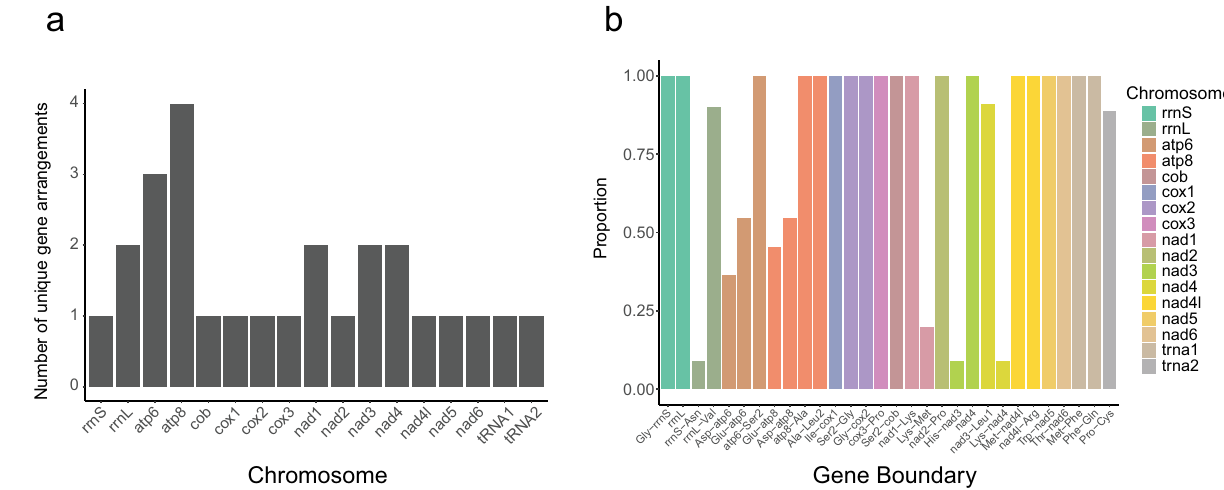
Fig. 3 Unique gene boundaries of mitogenomes within a single species of louse. a Unique gene arrangements on the 17 chromosomes of mitogenomes from 11 individual lice within the species Columbicola passerinae 2. b Proportion of the 11 individual lice from C. passerinae 2 that possess a particular gene arrangement. Genes listed alone indicate only a single gene is present on that particular